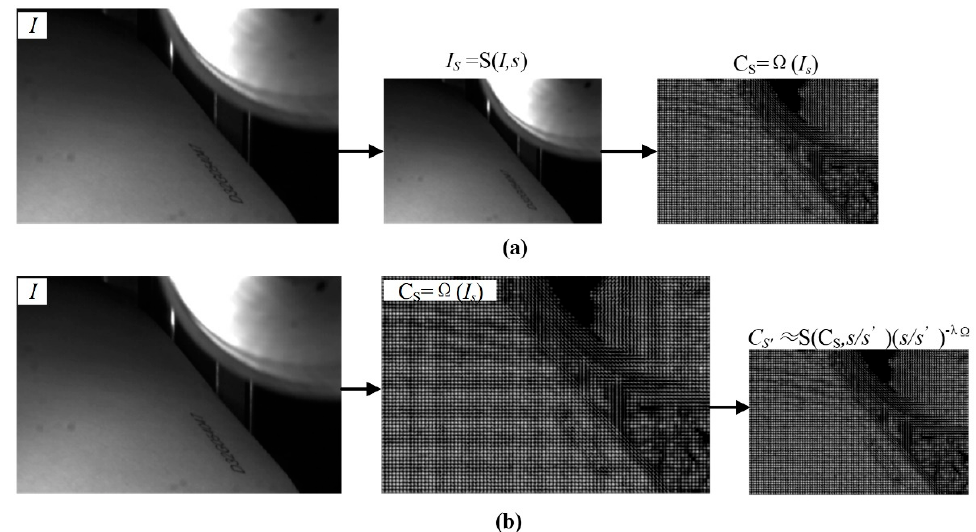
Figure 7. Schematic diagram of the fast feature pyramid: ( a ) normal computation method of FHOG features; ( b ) approximate computation method of FHOG features.